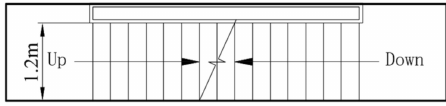
Figure 4. The single-run staircase.